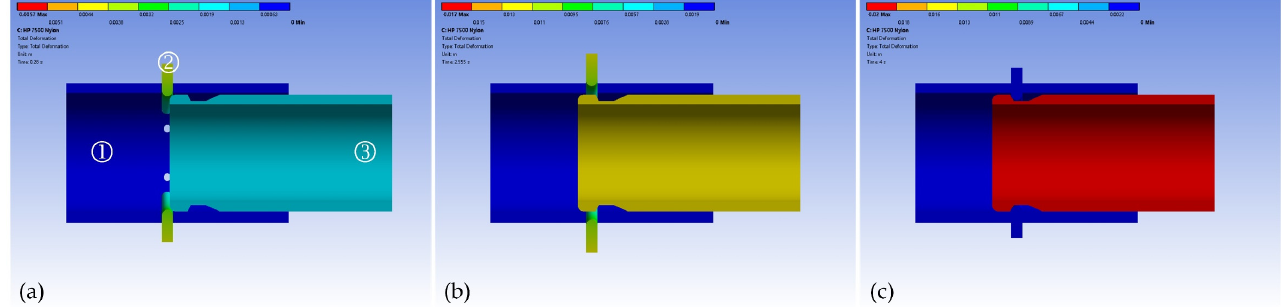
Figure 11. The mating process of the latching mechanism in the simulation: ( a ) the receptacle (part 3) starts engaging with the plug (part 1), ( b ) the receptacle is made the maximum engagement with the latching member (part 2), and ( c ) the plug and the receptacle are fully mated and interlocked by the latching member.